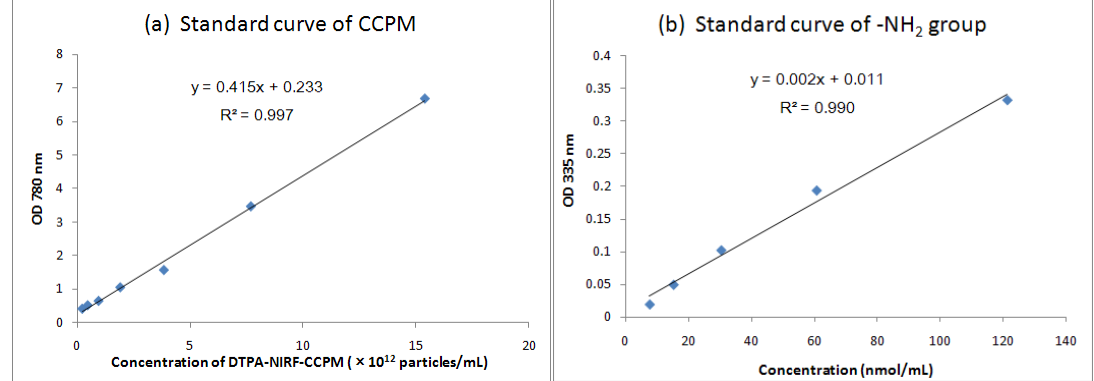
Figure 1. Standard Curve of ( a ) OD 780 nm absorption of DTPA-NIRF-CCPM. ( b ) OD 335 nm absorption of amines.